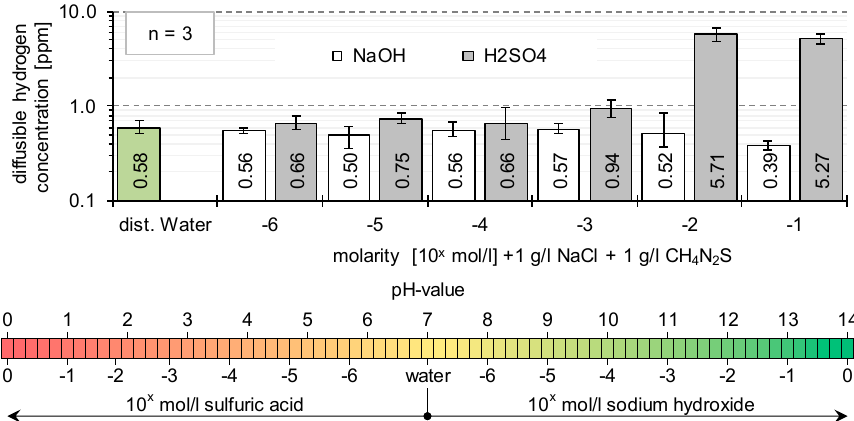
Figure 8. Impact of the pH value on the hydrogen concentration ( above ) at a current density of 100 mA/dm 2 and ( below ) the calculated pH-value from the respective molarity of the solution. The current density has a considerable influence on the hydrogen absorption (see Figure 9).